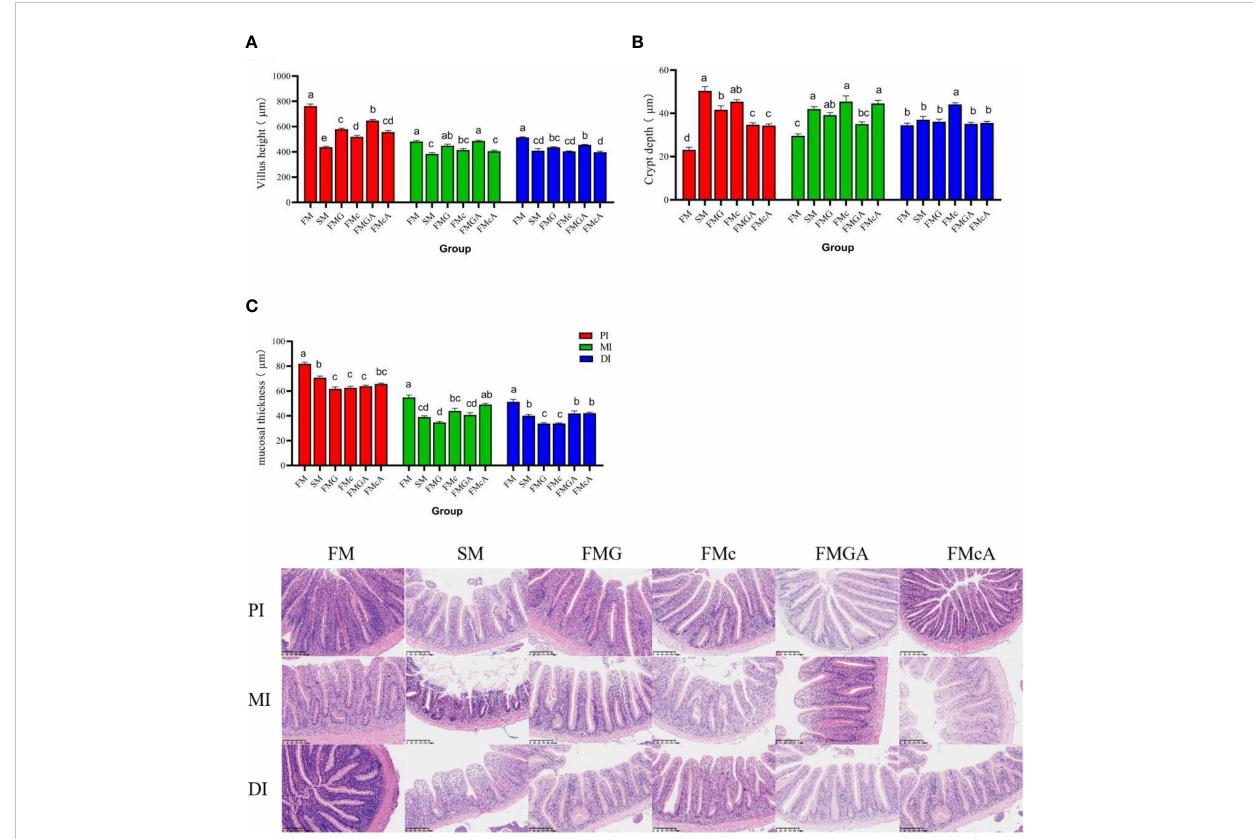
FIGURE 7 Morphology of the intestines of mirror carp at different treatments fed with diets containing fi shmeal (FM), soybean meal (SM)m glycinin (FMG), B- conglycinin (FMc), AKG+ glycinin (FMGA), AKG+B-conglycinin (FMcA) after eight weeks. PI, proximal intestine; MI, mid intestine; DI, distal instestine. (A) villus height (um); (B) crypt depth (um); (C) mucosal thickness (um). Data are presented as means + SE, (n = 3). a, b, c Mean values with different letters were signi fi cantly different